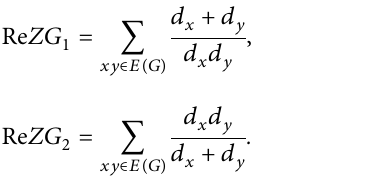
Table 1: Topological indices derived from M